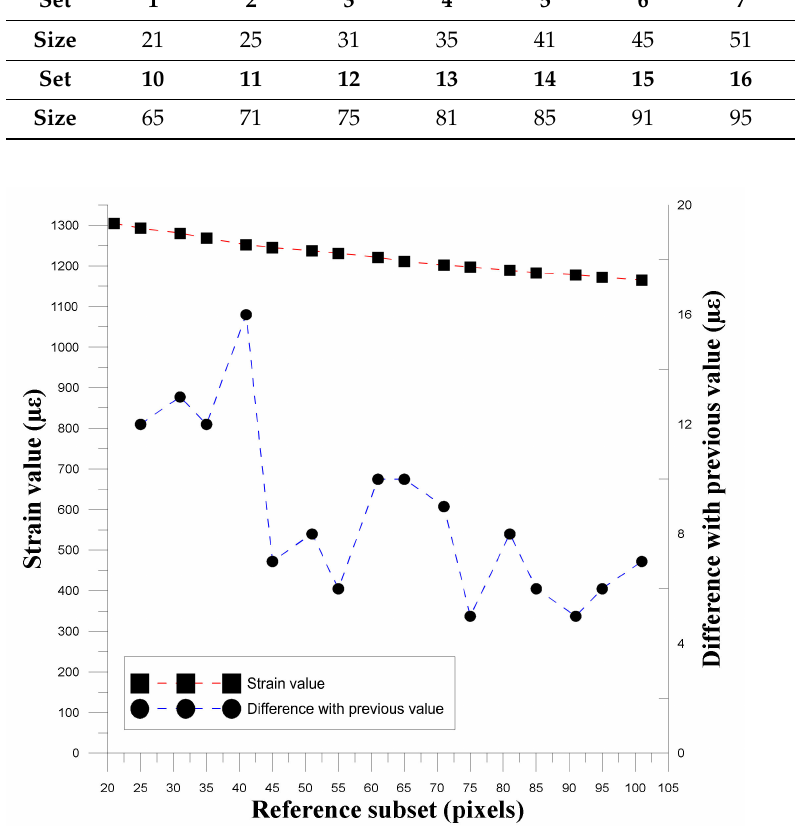
Figure 5. Trend graph of strain change and strain difference of the first set as the size of the reference subset